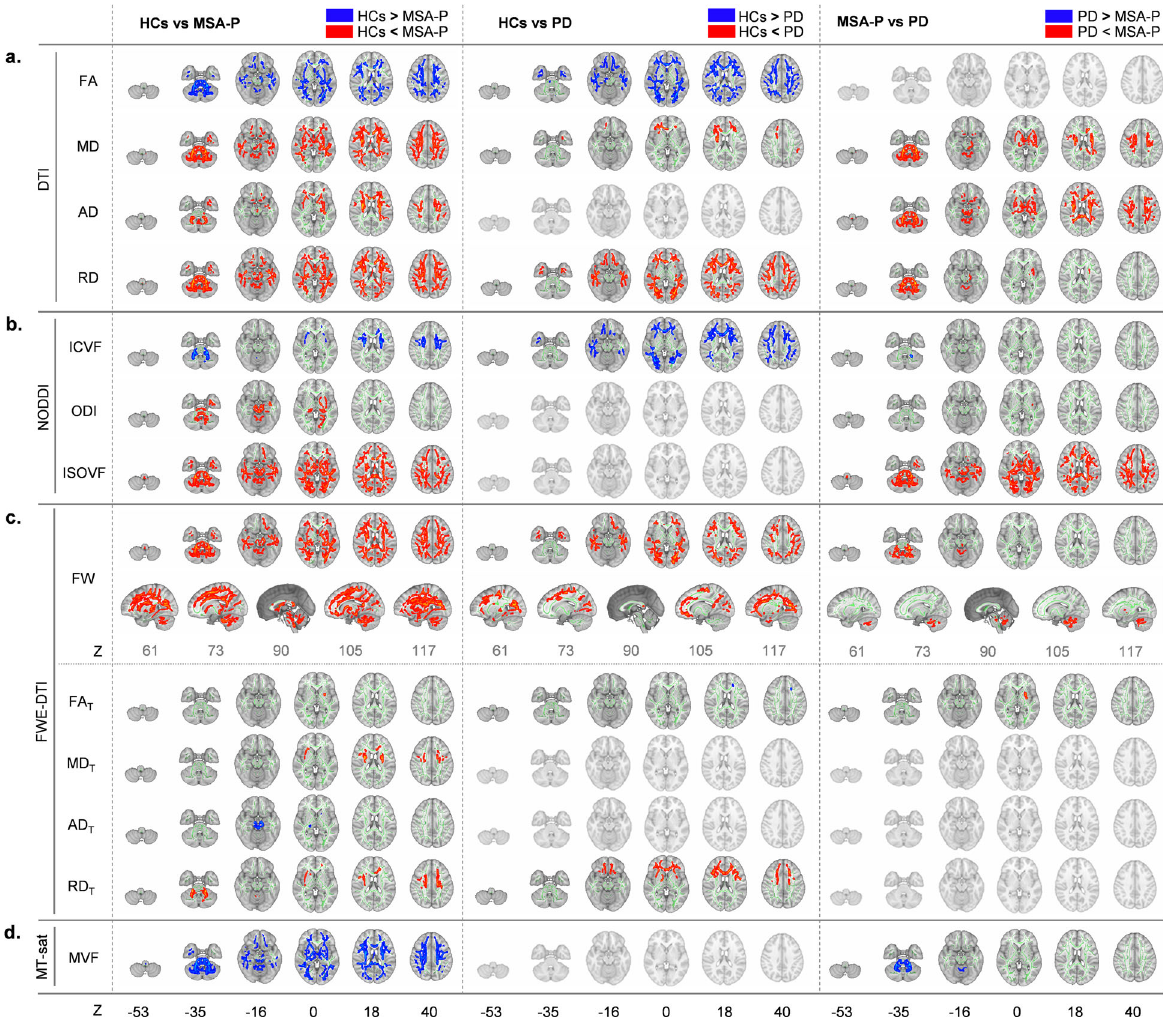
the CST of MSA-P patients compared with HCs and PD patients (Fig. 2, Supplementary Table 4). The substantia nigra pars compacta (SNc) was automatically applied to the automated anatomical labelling atlas 3 (AAL3) 20 , and the anterior (aSN) and posterior (pSN) regions were analyzed separately (Fig. 3). In the fi rst cohort, both the aSN and pSN had signi fi cantly higher ICVF and FA T in the MSA-P and PD patients compared with the HCs, and signi fi cantly lower RD T . The FW was signi fi cantly higher in the aSN of PD patients compared with HCs, whereas in the pSN it was signi fi cantly higher in both MSA-P and PD patients compared with HCs (Fig. 4, Supplementary Table 5). Similar results were observed in the second cohort, especially for FA T and RD T (Fig. 4, Supplementary Table